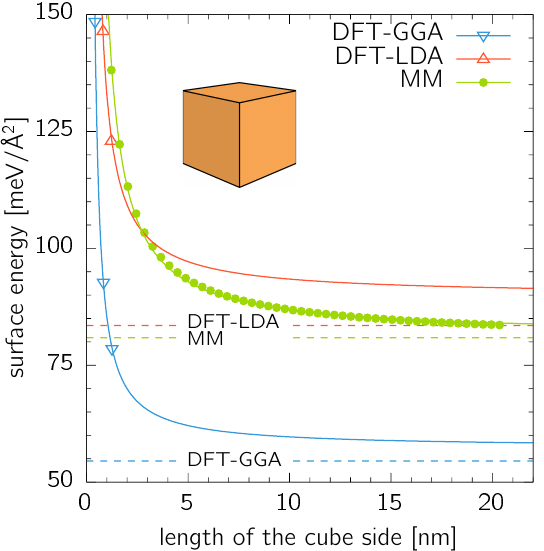
Figure 2. Surface energy of nanocubes calculated by DFT and MM. The calculated datapoints were fitted with Equation (3). The dashed lines are ( 100 ) surface energies as listed in Table 1.